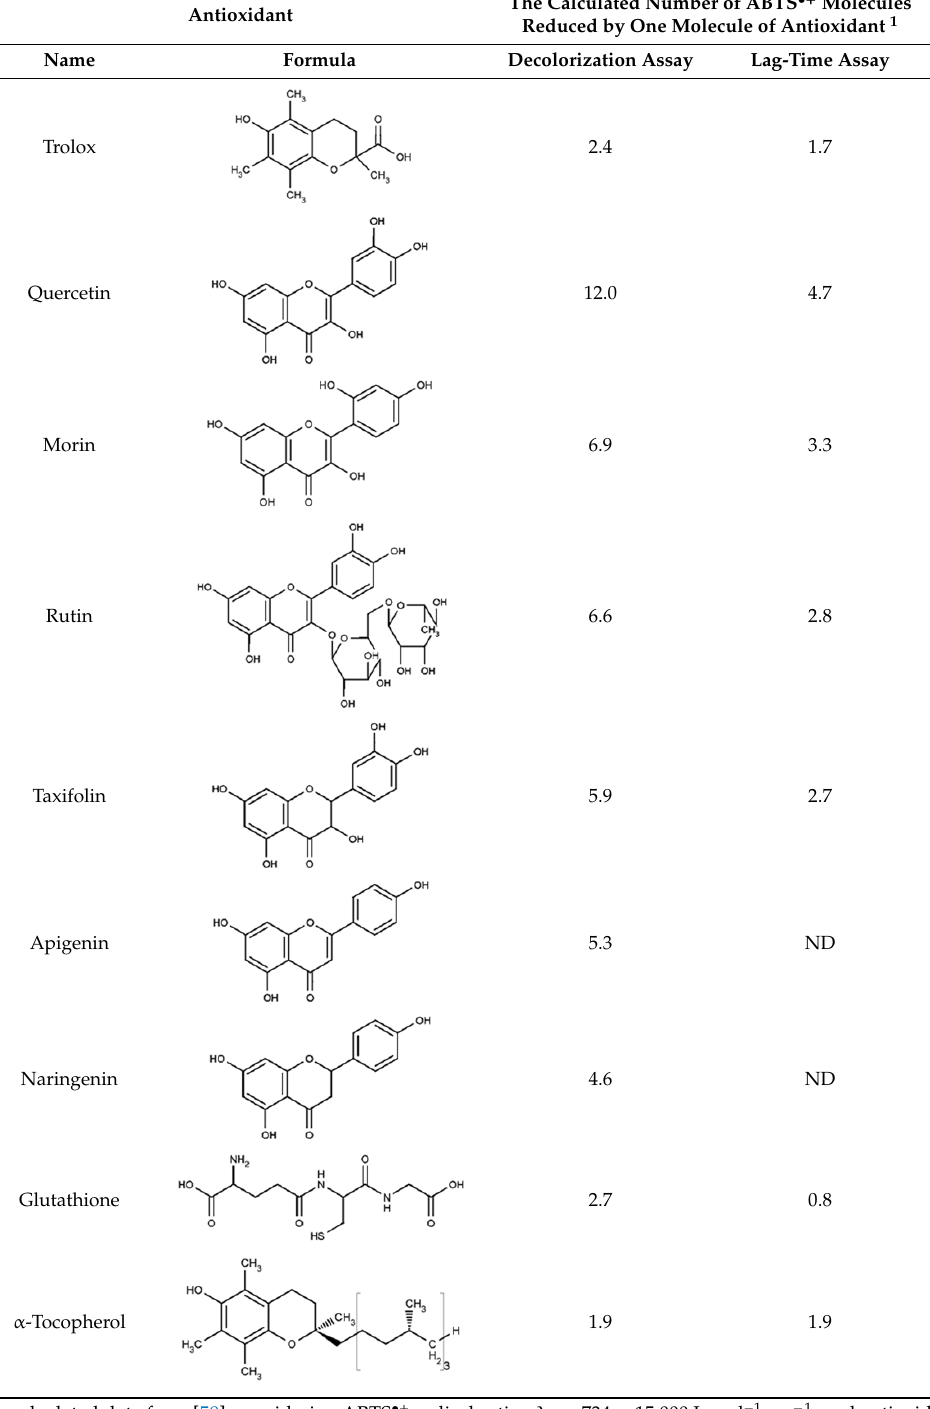
Table 3. The comparison of the number of ABTS • + molecules reduced by one molecule of antioxidant in decolorization and lag-time assays. The Calculated Number of ABTS •+ Antioxidant Molecules Reduced by One Molecule of